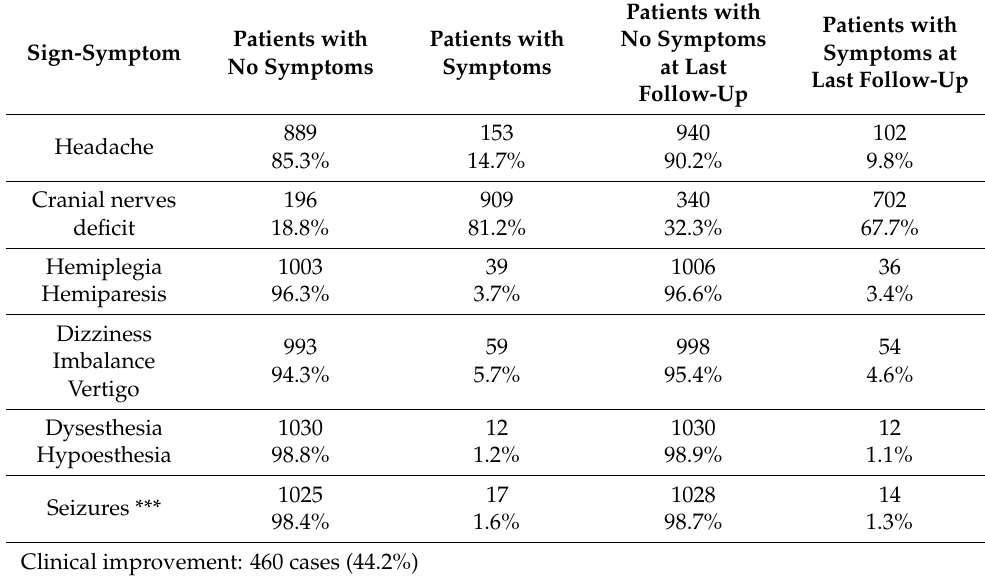
Table 6. Clinical neurological picture before SRS (left columns) and at last follow-up (right columns) *, **.